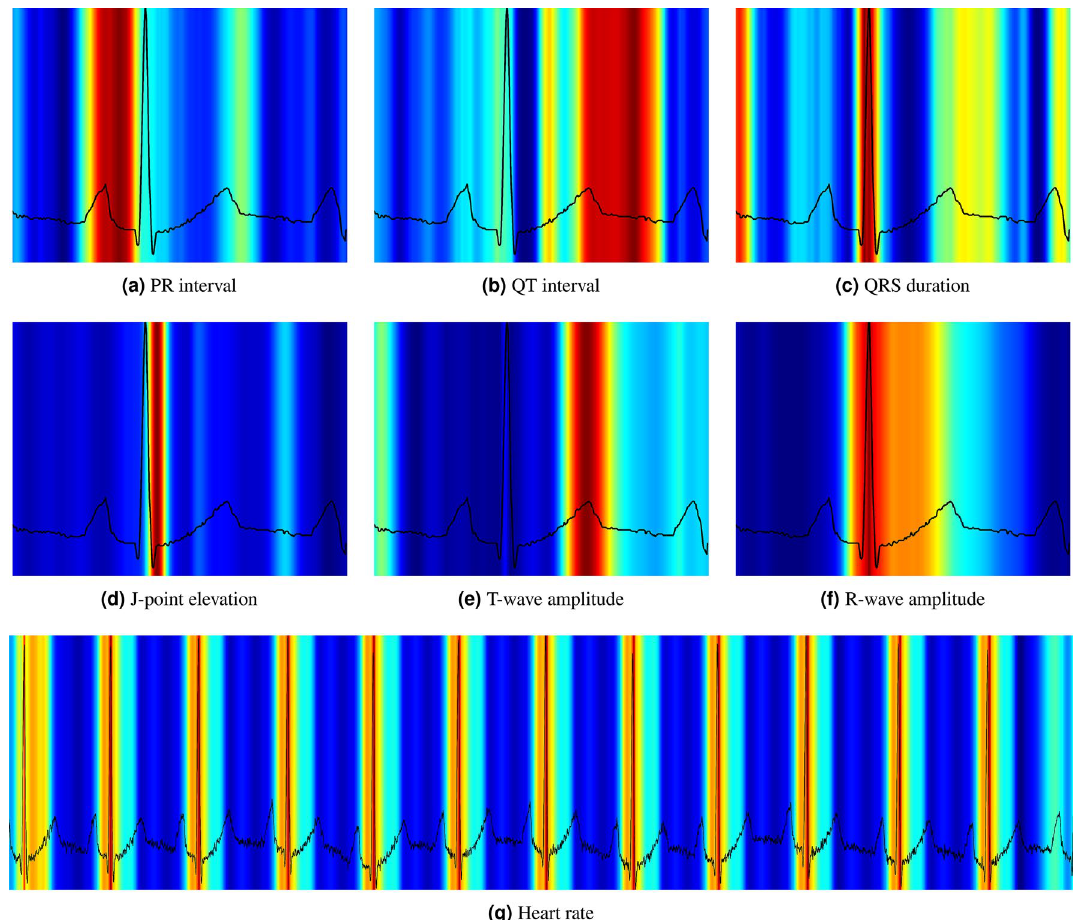
Figure 3. Visualization of the attention maps generated for the interval and amplitude prediction models. As we can see from the plots, the model learns to inspect the waves and intervals that are related to the predicted variable. Red color indicates high importance and blue color low importance of the ECG for the decision of the neural network.